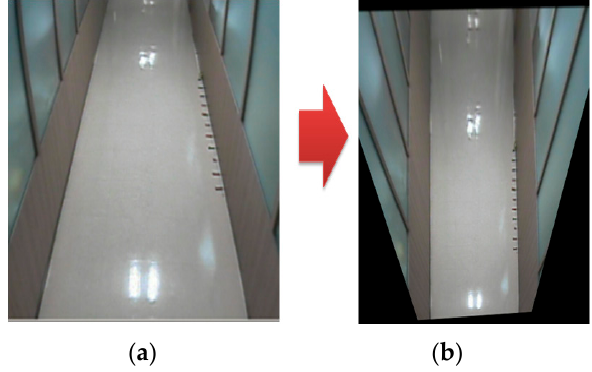
Figure 2. ( a ) Original image; ( b ) Air view image of ( a ).